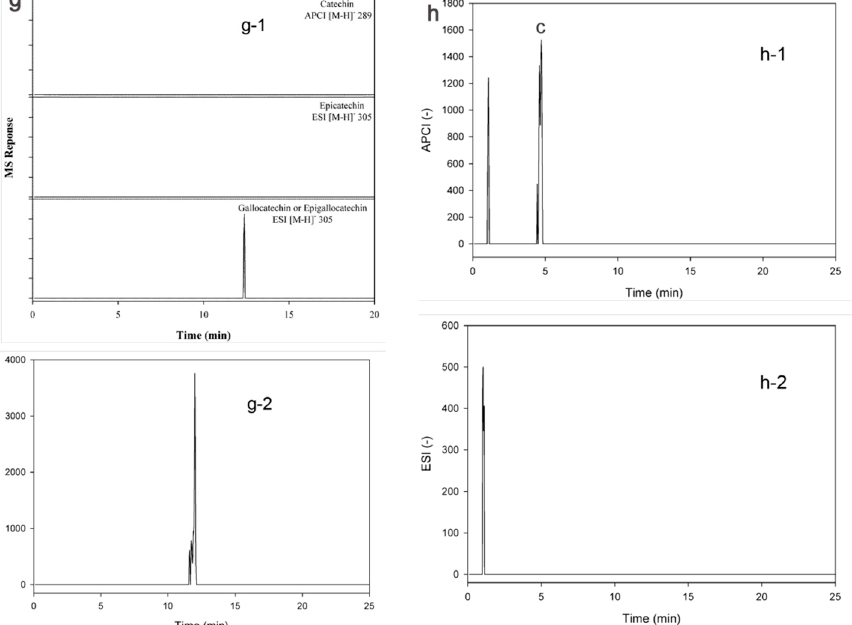
Figure 4. Recombinant expression of three MiANRs and their catalytic activity analysis. ( a ) SDS–PAGE (12%) gel electrophoresis of recombinant MiANR1-1 and MiANR1-2 proteins stained with Commassie brilliant blue G250. lane1: prestained protein mass markers (New England Biolabs), lane 2: 10 µ g crude extract from E. coli BL21 harboring pET28b, lane 3:10 µ g crude extract from uninduced BL21 harboring pET28bMiANR1-1, lane 4:10 µ g crude extract from induced E. coli BL21 harboring pET28bMiANR1-1, lane 5:10 µ g purified MiANR1-1, lane 6:10 µ g crude extract from uninduced E. coli BL21 harboring pET28bMiANR1-2, lane 7:10 µ g crude extract from induced E. coli BL21 harboring pET28bMiANR1-2, lane 7: 20 µ g purified MiANR1-2; ( b ) lane 1: prestained protein mass markers(New England Biolabs); lane 2: 10 µ g crude extract from E. coli BL21 harboring pET28b, lane 3:10 µ g crude extract from uninduced BL21 harboring pET28bMiANR1-3, lane 4: 10 µ g crude extract from induced E. coli BL21 harboring pET28b MiANR1-3, lane 5:10 µ g purified MiANR1-3; ( c ) UPLC-MS profiles show